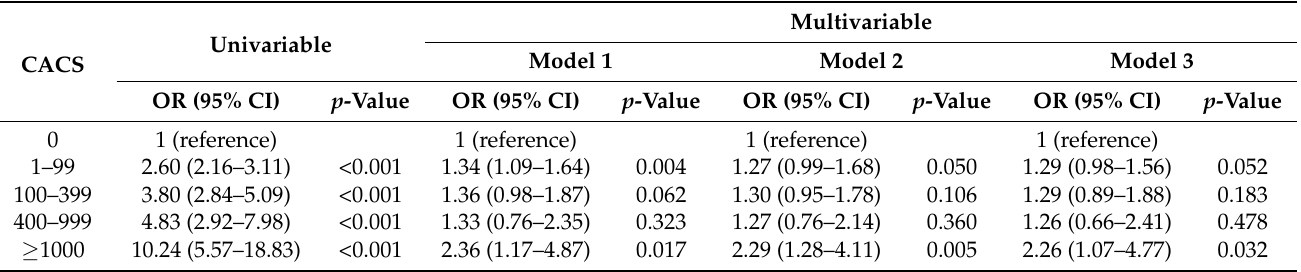
Table 2. Multivariable logistic regression analyses for the relationship of coronary artery calcium score and atrial fibrillation in total 143,529 participants.